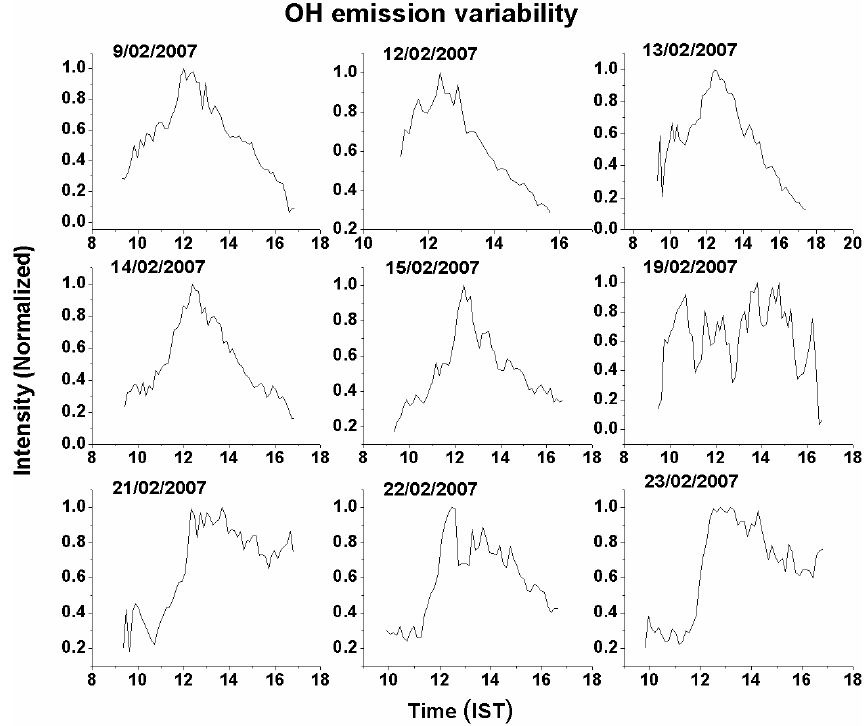
Fig. 5. Same as Fig. 4 but for the OH